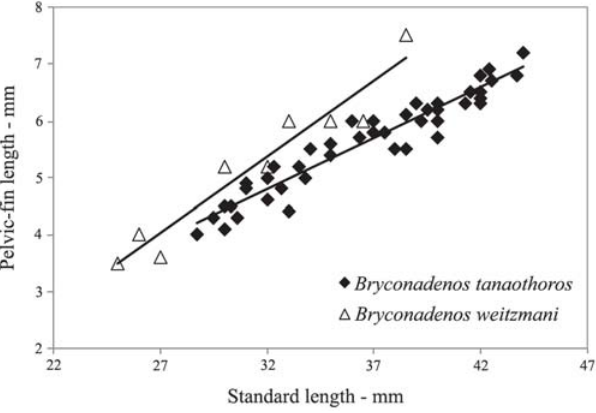
Fig. 4. Pelvic-fin length as a function of standard length by sex for males and females of Bryconadenos weitzmani . For explanation see text under sexual dimorphism.